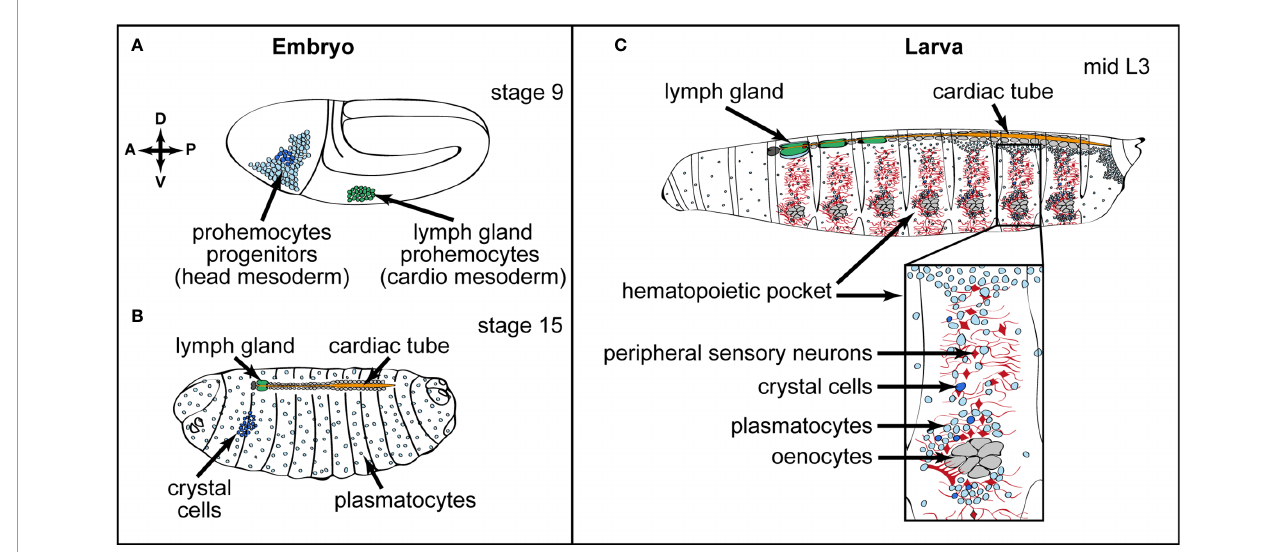
FIGURE 1 | Embryonic and larval hematopoiesis. (A, B) Embryonic hemocytes (blood cells) originate from the head mesoderm in the embryo and differentiate into plasmatocytes (macrophages, light blue) and a small number of crystal cells (dark blue). Lymph gland progenitors (green) are speci fi ed from the thoracic cardiogenic mesoderm in the embryo (A) Anterior (A)/Posterior (P) and Dorsal (D)/Ventral (V) axes are indicated. (B) At the end of embryogenesis, crystal cells remain clustered in the anterior part, whereas plasmatocytes are dispersed throughout the embryo. The lymph gland is composed of one pair of lobes and is localized at the anterior part of the dorsal vessel/cardiac tube. (C) In third instar larvae, plasmatocytes (light blue) and crystal cells (dark blue) of embryonic origin are found in circulation and colonizing local microenvironments, in particular the hematopoietic pockets, where they expand. Close up of a hematopoietic pocket where neurons are in red, oenocytes in grey, and plasmatocytes and crystal cells in light and dark blue, respectively. Activin- b produced by PNS neurons promotes plasmatocyte proliferation and adhesion. The lymph gland (green) is composed of several pairs of lobes aligned along the cardiac